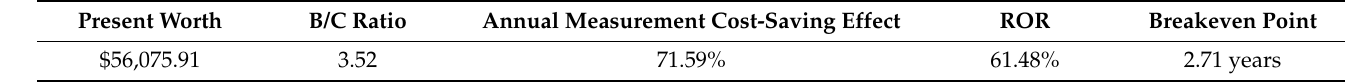
Table 10. Economic analysis results.